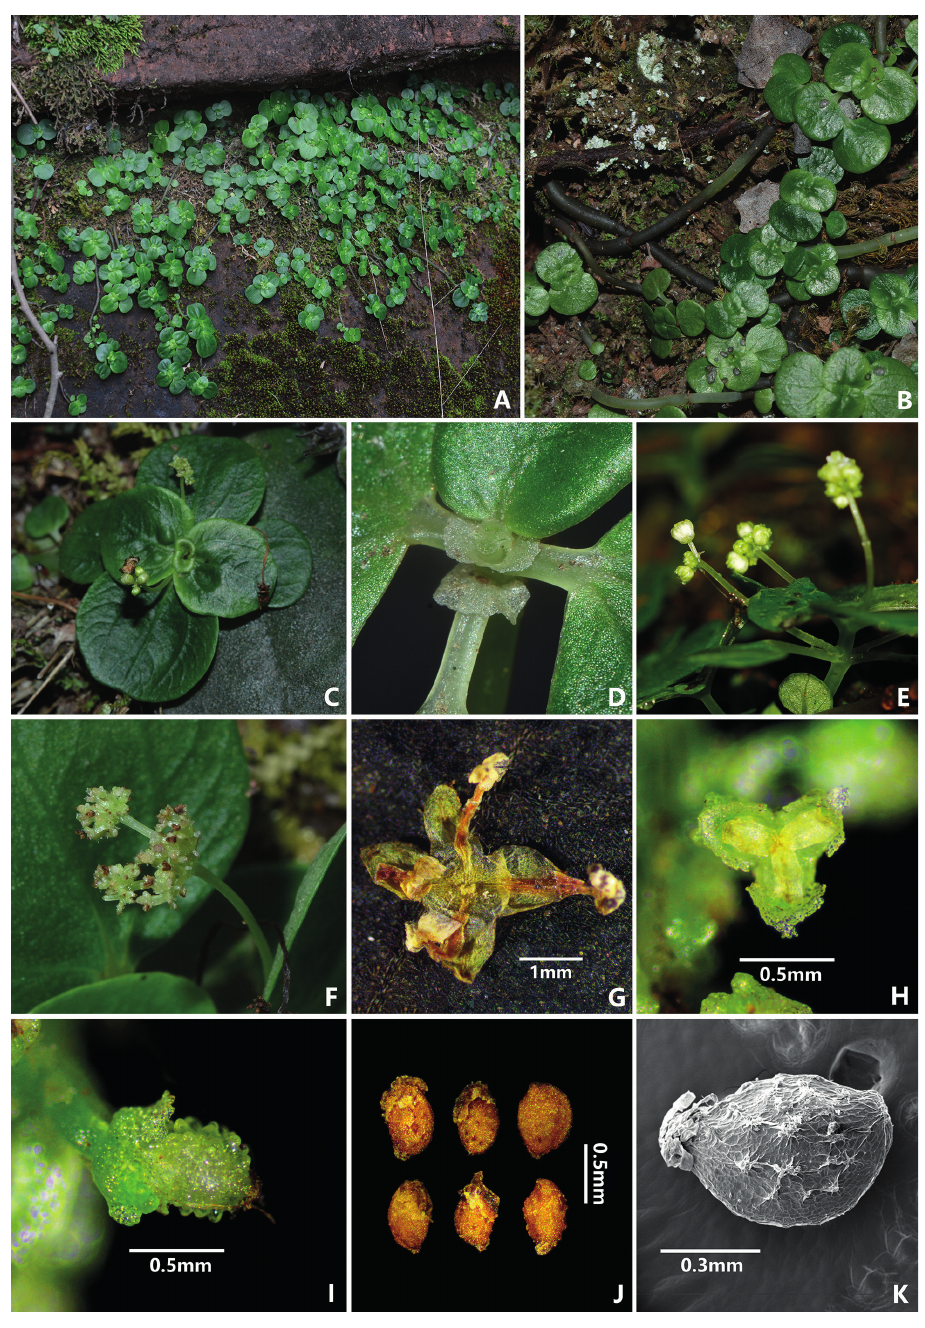
Figure 3. Plate of Pilea danxiaensis A habitat B habit C leaves and inflorescence D stipules E staminate inflorescence F pistillate inflorescence G staminate flower H pistillate flower I achene with pistillate sepals J LM of achene K SEM of